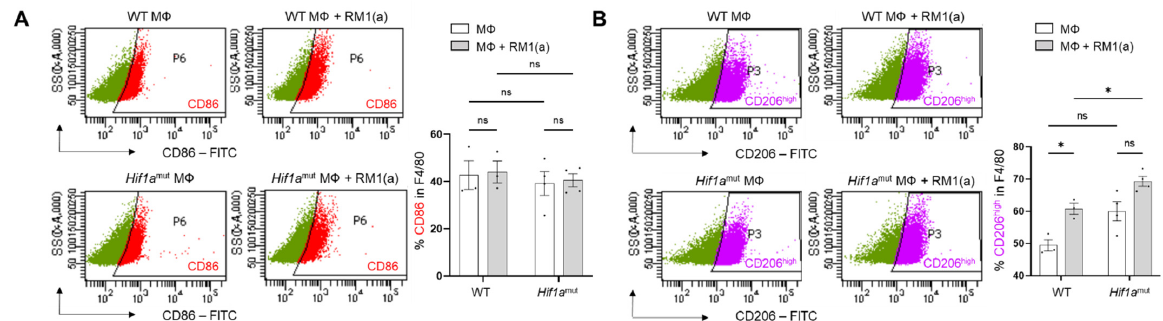
Figure A8. Analysis by flow cytometry of CD86 and CD206 expression in efferocytic BM macrophages from WT and Hif1a mut mice. BM macrophages (M Φ ) were isolated from 4 wk old Hif1a flox/flox (WT) ( n = 3), Hif1a mut ( n = 4) mice and co-cultured with apoptotic RM1 cells (RM1(a)) for 16–18 h. Efferocytic and non-efferocytic macrophages were labeled with F4/80-APC, CD86-FITC, CD206-FITC or isotope antibodies and analyzed by flow cytometry. Graphs show the percentages of CD86 + ( A ) or CD206 + ( B ) cells in F4/80 + populations of efferocytic (M Φ + RM1(a)) and non-efferocytic (M Φ ) BM macrophages from WT and Hif1a mut mice. Each plot is representative of cells gated from F4/80 + populations. Plotted data are shown as mean ± SEM, * p < 0.05, ns = not significant (ordinary one-way ANOVA; Tukey’s multiple comparison test).